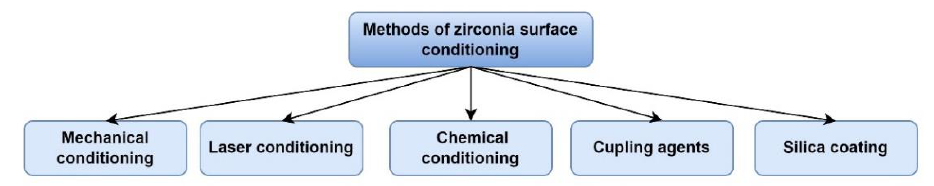
Figure 2. Surface modification